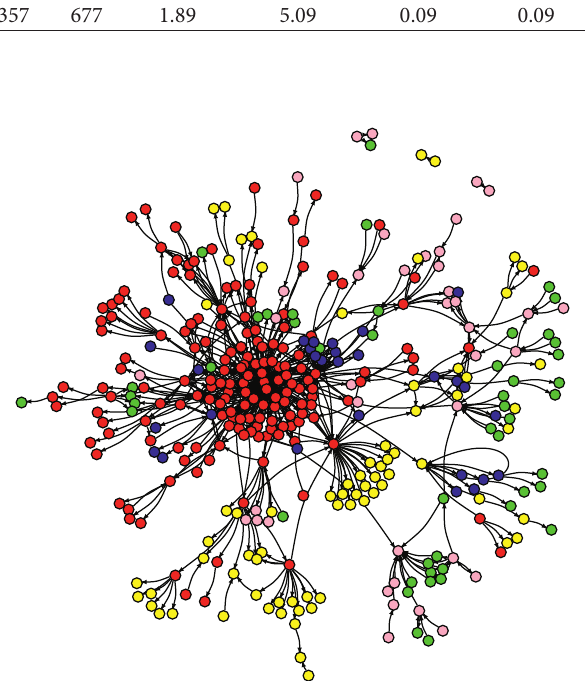
Figure 2: The Tianjin Port blast response network by funding source. Red � public, yellow � public institution, blue � state- owned, pink � nonprofit, green �